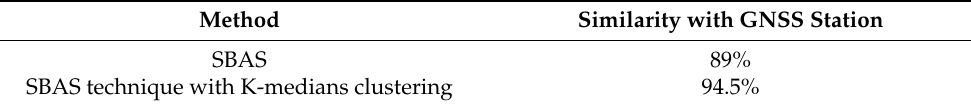
Table 5. Percentage of similarity for deformation value obtained from selected clustering methods applied to results from the GNSS